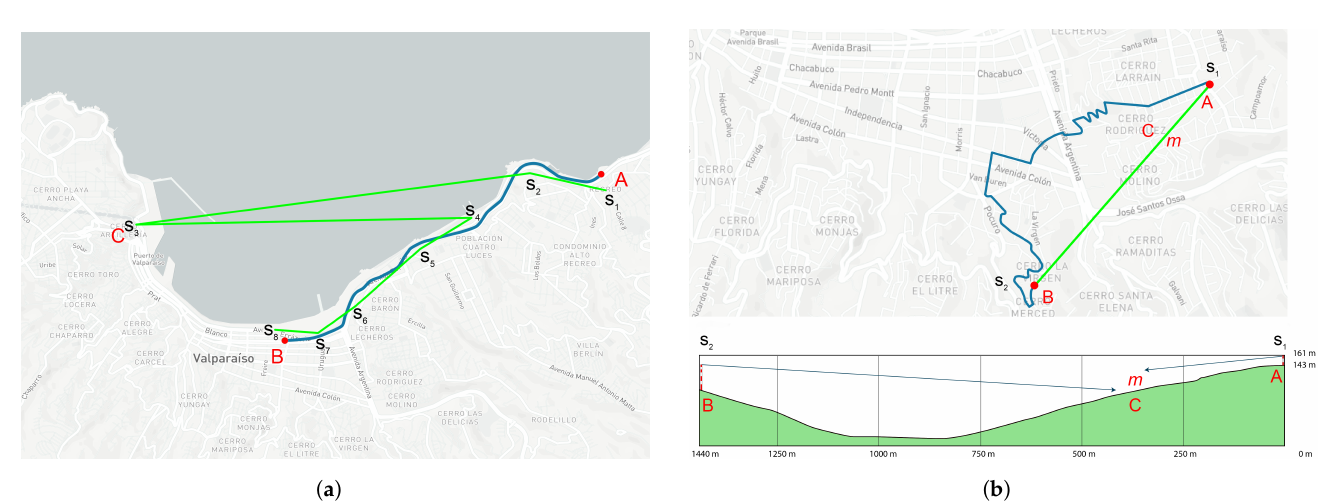
Figure 2. Two of the most frequent problems that the data wrangling process presents. Both have negative implications in the computation of aggregate distances in urban mobility. ( a ) Elevation profile between two cell sites in Valparaíso that creates an NNH connection. ( b ) Example of notable differences between Euclidean, Manhattan, and real distances between two points in the city. This condition is common in hilly